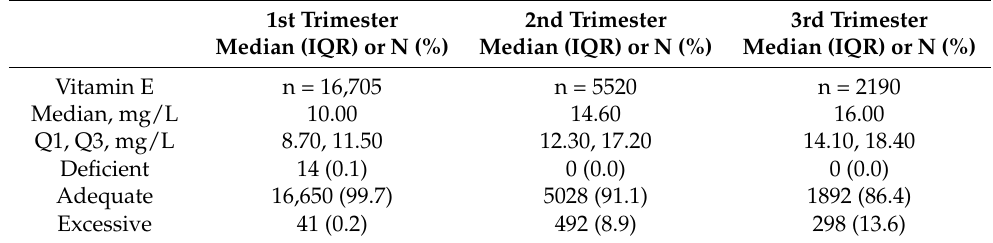
Table 2. Vitamin E levels during pregnancy.